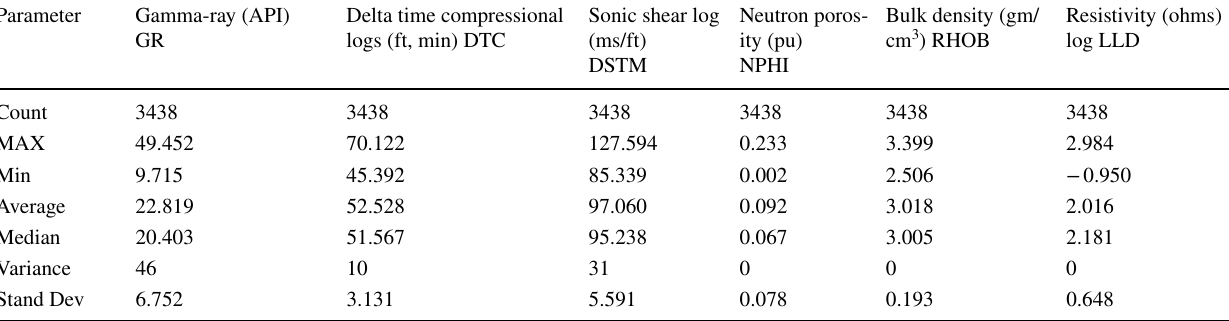
Table 1 Collected data with statistical